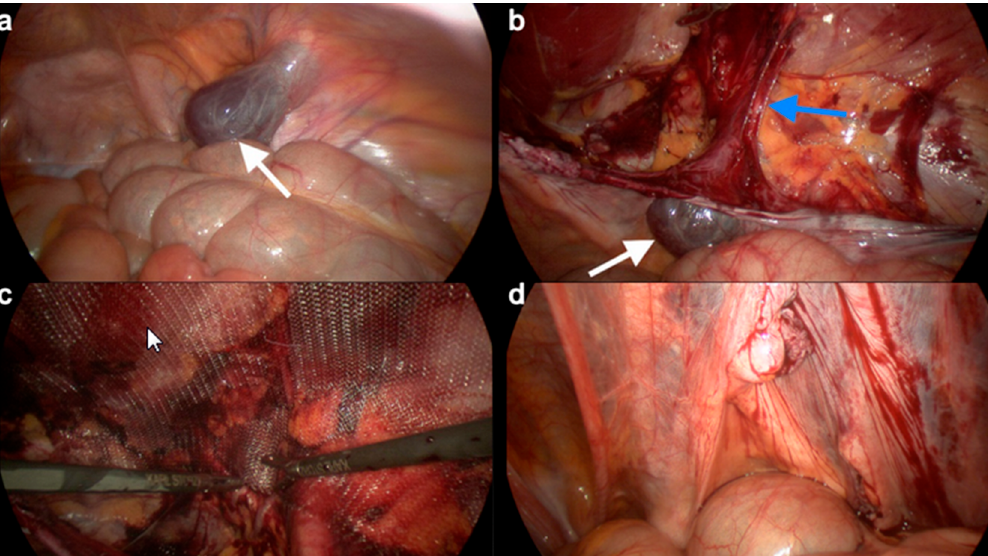
Figure 2. Laparoscopic procedures for hydrocelectomy and TAPP. ( a ) In the laparoscopic view, a type 2 hydrocele of the canal of Nuck (white arrow) ( b ) Approach to the inguinal canal and dissection of the hydrocele (white arrow) attached to the round ligament (below blue arrow). ( c ) Placement of the polypropylene mesh. ( d ) Sutured peritoneum.